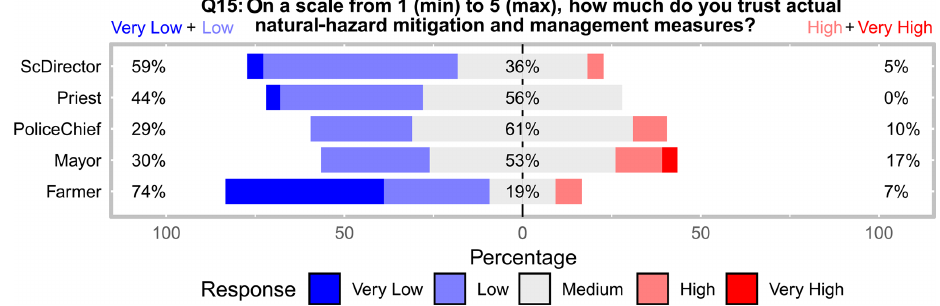
Figure 11. The Likert plot of the stakeholders’ responses regarding the trust in the actual measures for natural hazard mitigation and